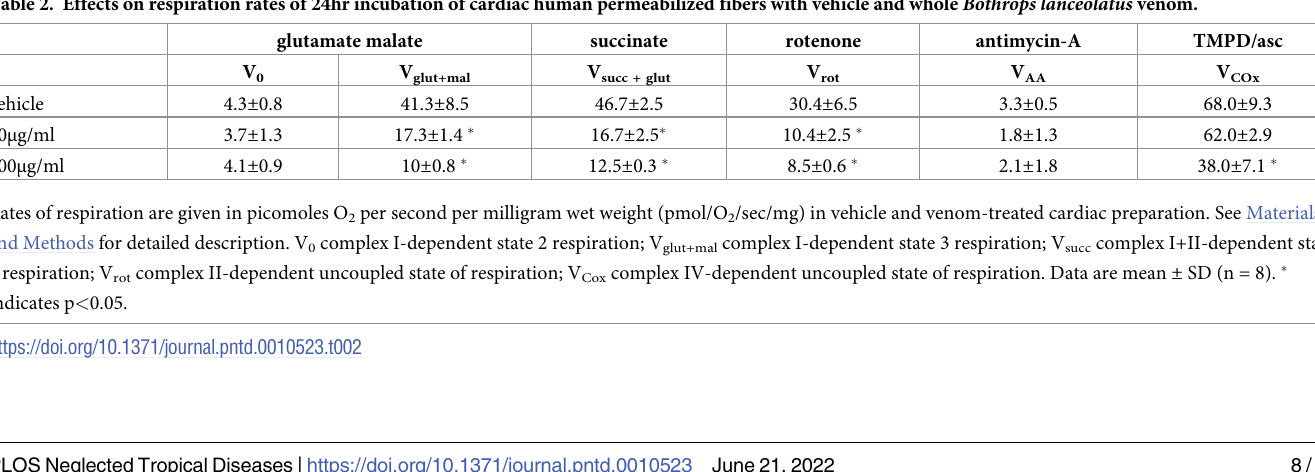
Table 2. Effects on respiration rates of 24hr incubation of cardiac human permeabilized fibers with vehicle and whole Bothrops lanceolatus venom.